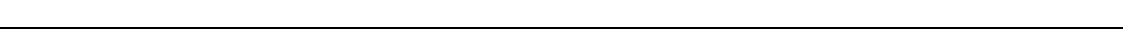
Fig. 6 Subcellular localizations and biological processes of dimer- or monomer-speci fi c partner proteins. a Interaction network for proteins associating